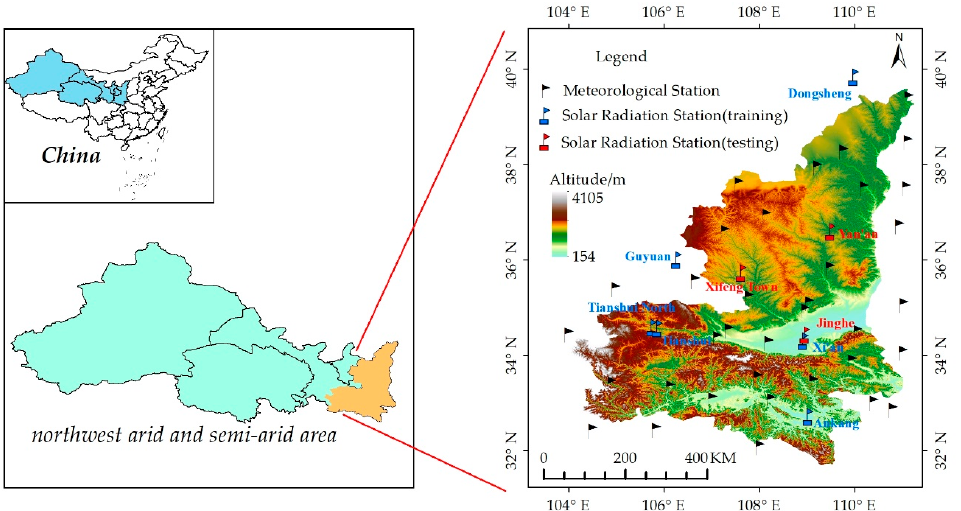
Figure 1. Location of the study area.